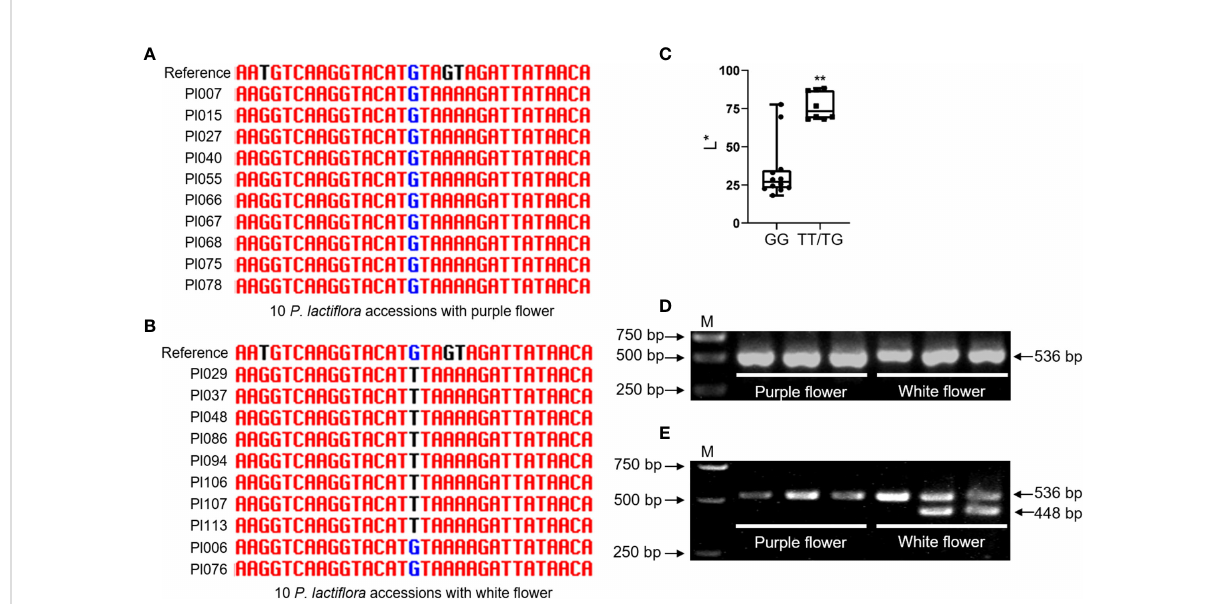
FIGURE 7 Genotyping of different P. lacti fl ora cultivars using a 270512F_4769-based dCAPS marker. (A) Ampli fi cation of 270512F-based fragment in 10 P. lacti fl ora cultivars with purple fl ower, randomly. (B) Ampli fi cation of 270512F-based fragment in 10 P . lacti fl ora cultivars with white fl ower, randomly. (C) Box plot for the L* of individuals with different SNP allele. Each dot represents an individual. (D) PCR products of three randomly selected cultivars with purple fl ower and three randomly selected cultivars with white fl ower using the dCAPS primer. (E) Polymorphism analysis of dCAPS marker in individuals with different colors. **Signi fi cant difference at P < 0.01, as calculated by Student ’ s t test. M represents DNA